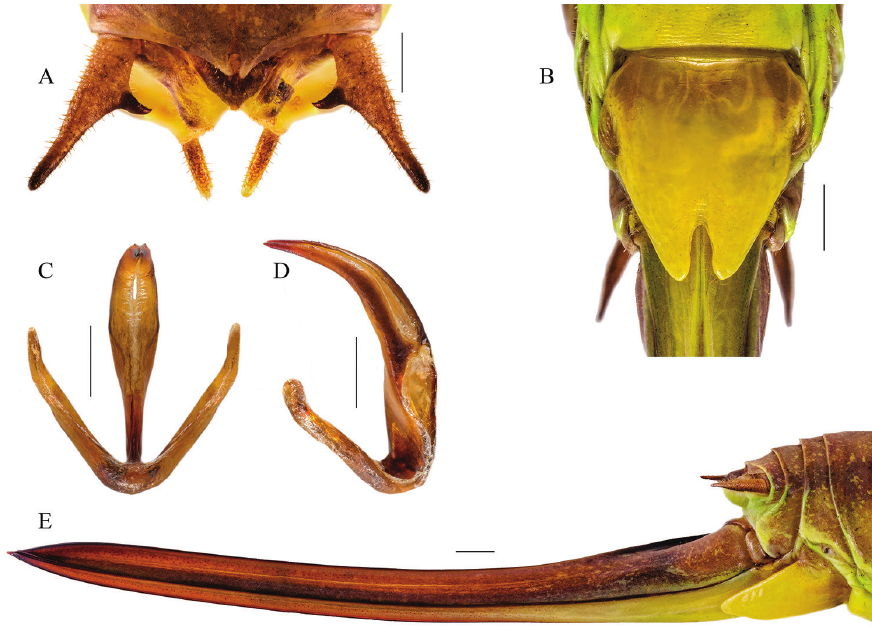
Figure 6. The eidonomy of Parapholidoptera castaneoviridis specimens from south-eastern Romania: A male cerci B female subgenital plate C, D titillator E ovipositor. Scale bar 1